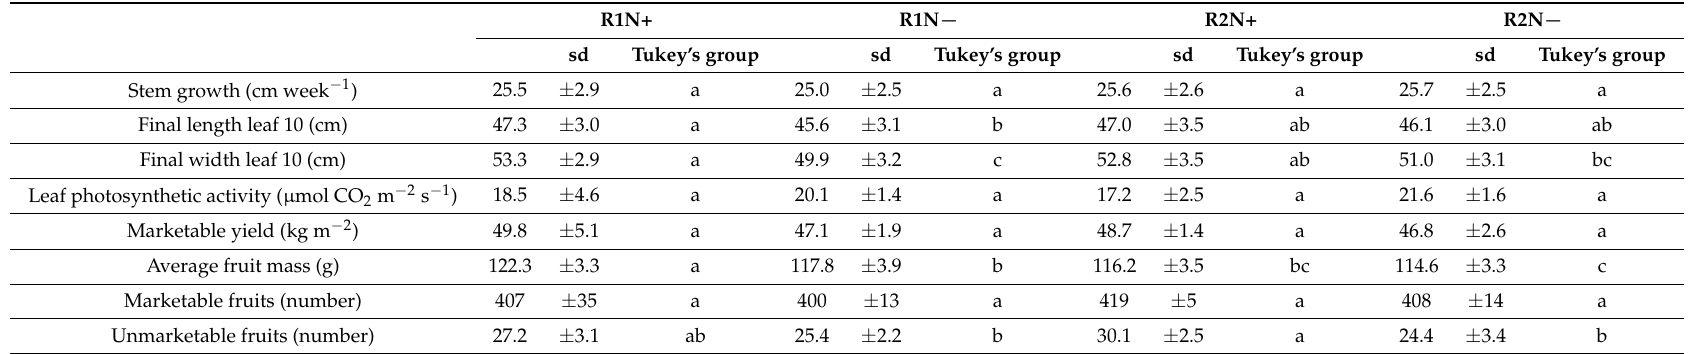
Table 1. Plant architecture (stem growth and leaf length and width), photosynthetic activity and agronomic performance (yield, average fruit mass and number of marketable and unmarketable fruits) of tomato crops replicates 1 (R1) and 2 (R2) according to nitrogen supply N+ and N − . sd stands for standard deviation. Letters indicate results of statistical analysis according to Tukey’s test: different letters within the row indicate statistical differences.